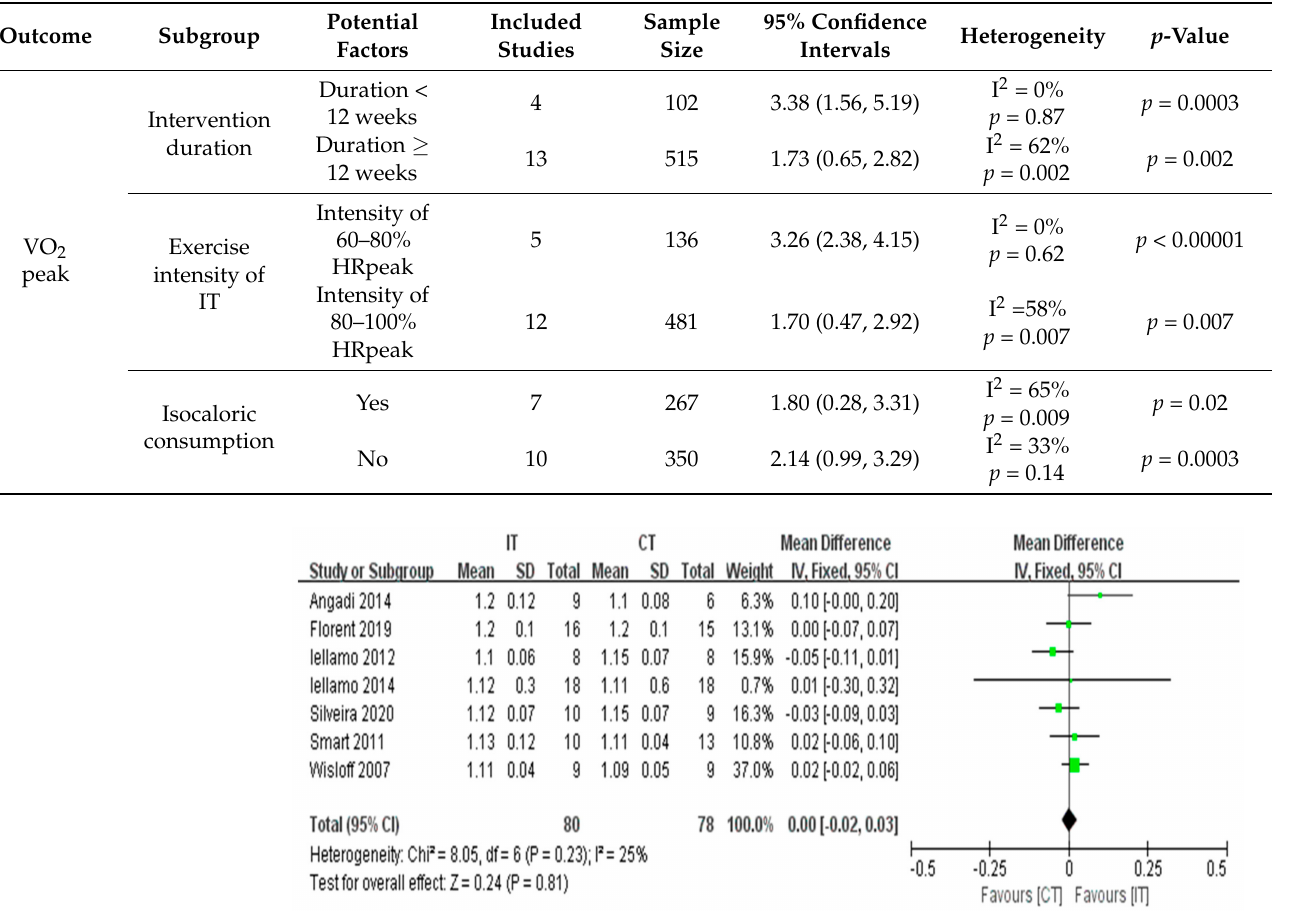
Figure 4. Forest plot: Effects of the